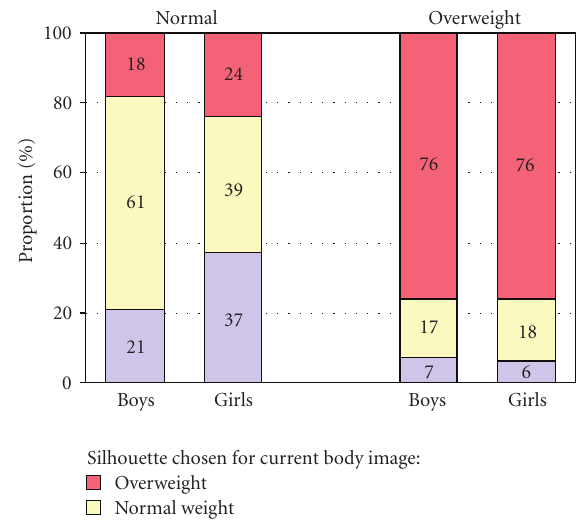
Silhouette chosen for current body image: Overweight Normal weight Underweight Figure 1: Self-perceived body image based on Stunkard’s silhou- ettes according to sex and actual weight